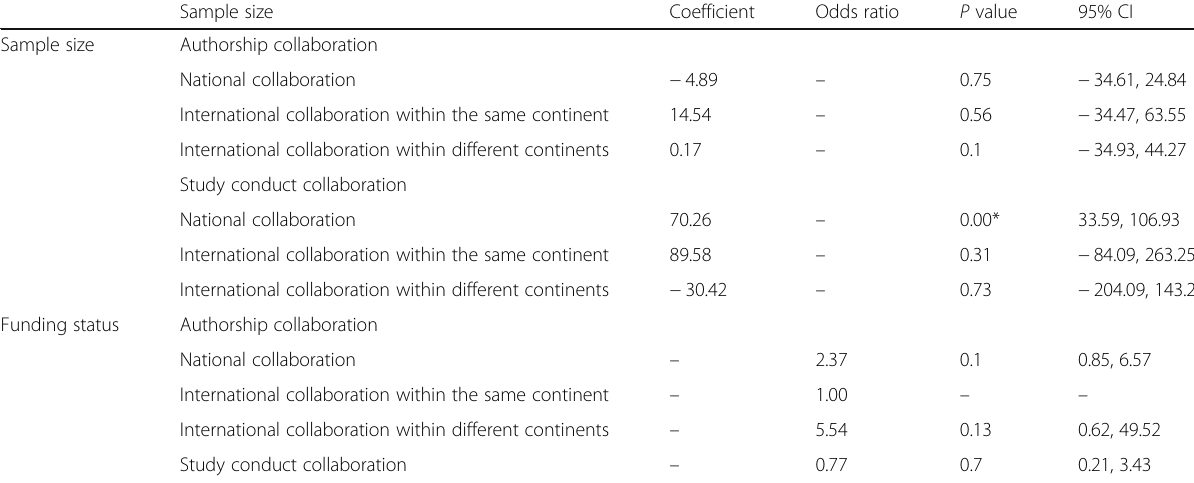
Table 3 Results of linear and logistic regression analyses Sample